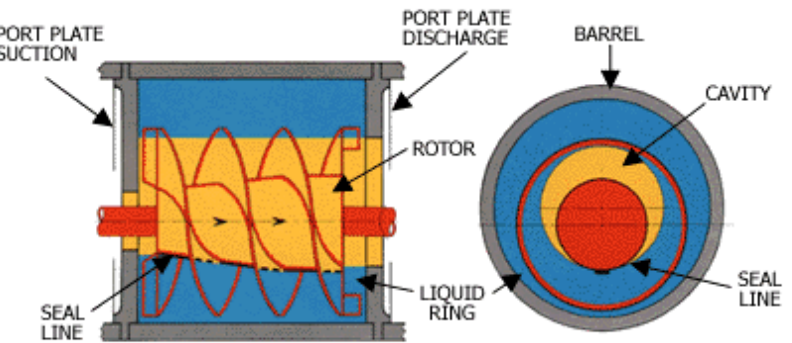
Figure 3. Detailed view of a Liquivac pump (Reprinted with permission from ref. [13]. Copyright 2021 Wiley)